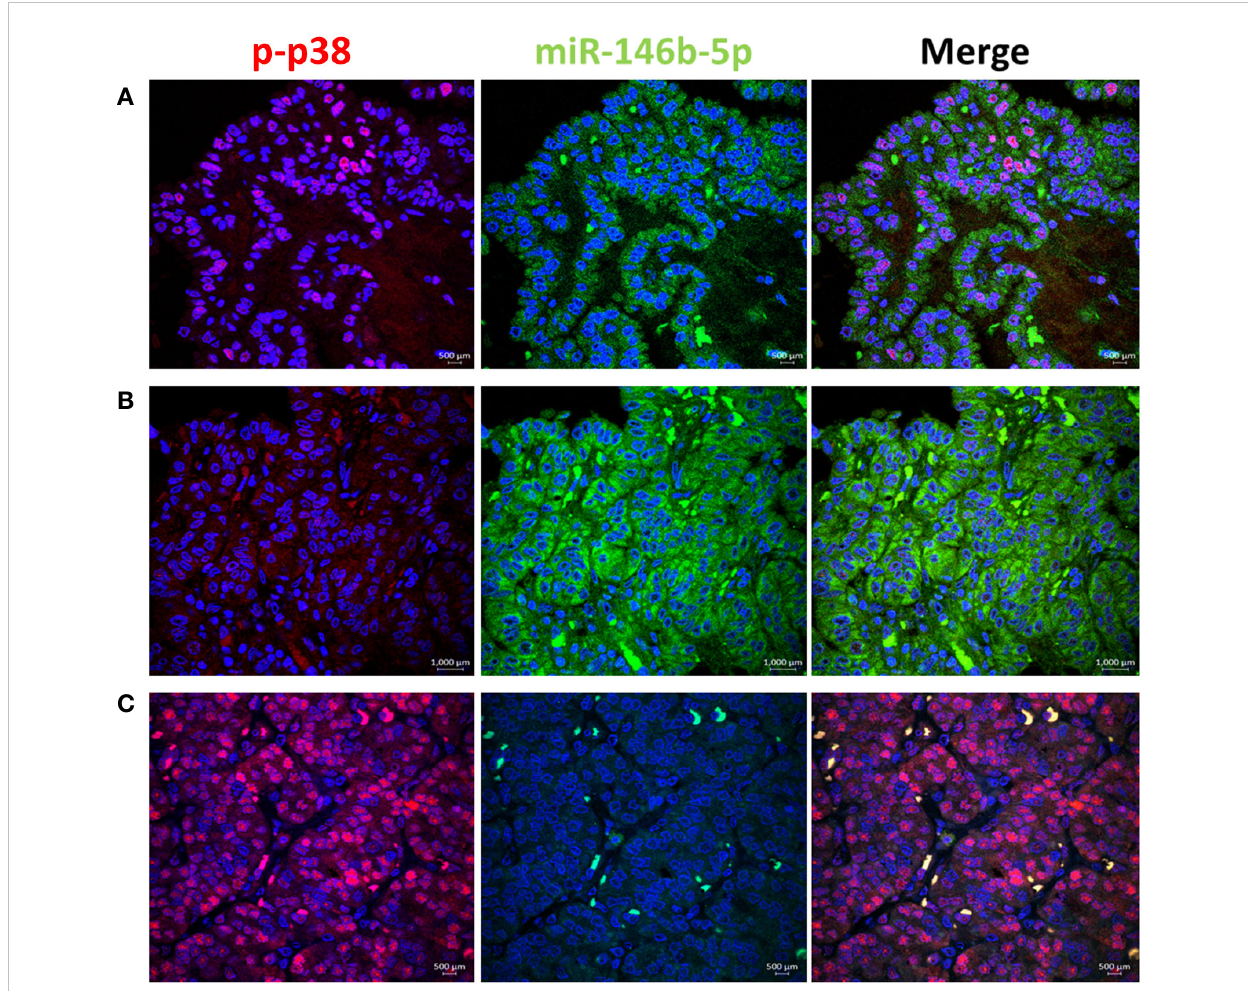
FIGURE 5 p38 pathway activity in relation to miR-146b-5p expression in representative thyroid tissues. (A) In PTC phospho-p38 is detected in the nuclei of tumor cells with low expression of miR-146b-5p. (B) p-p38 is negative in areas of miR-146b-5p high expression. (C) In NIFTP strong nuclear expression of p-p38 is detected with no expression of